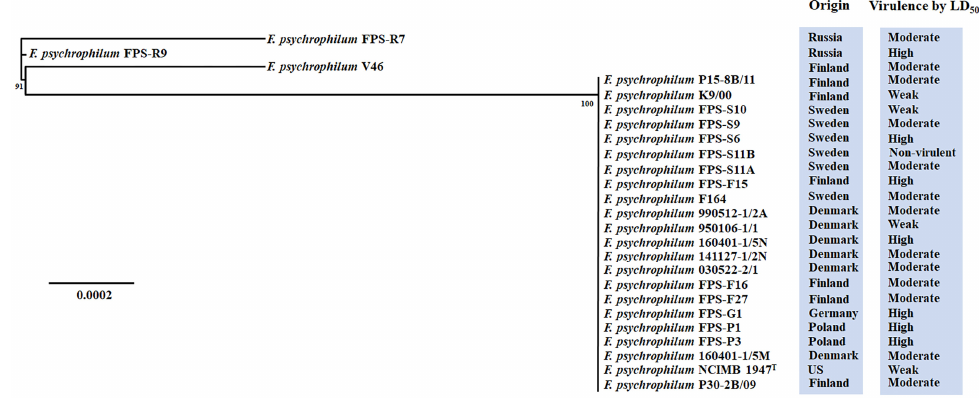
Figure 3. Phylogenetic tree of 109 concatenated virulence-related factors shared by all F. psychrophilum isolates. The phylogenetic tree was constructed based on the maximum likelihood algorithm, using a concatenated alignment of 109 amino acid sequences inferred from putative virulence-related factors identified in the pan genome analysis (Table S2). The numbers above the branches indicate the bootstrap value. The horizontal bar at the base of the figure represents 0.0002 substitutions per amino acid site. The virulence ranking and origin of isolation for each isolate was added to facilitate comparison.